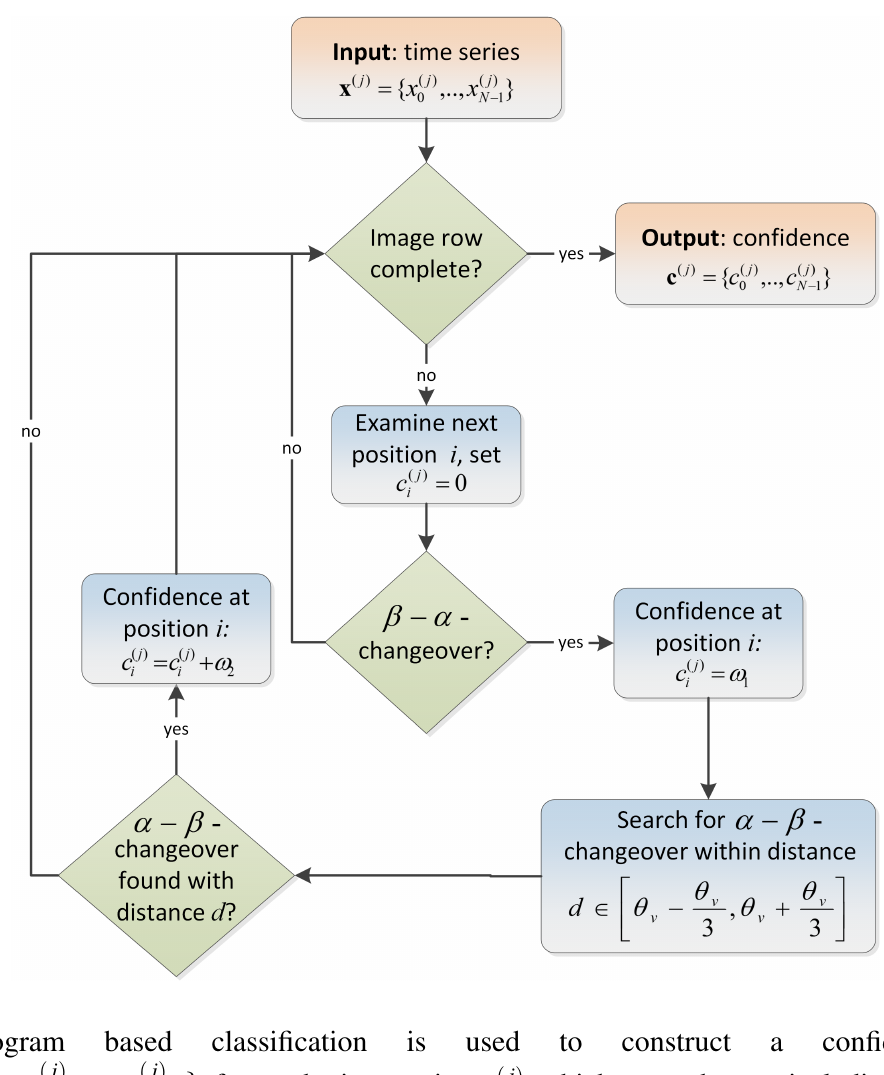
Figure 10. Flow chart for constructing confidence vectors c ( j ) for a particular time series x ( j ) . Input and output is visualized in Figure 11a,c. α represents predefined marker candidate pixels based on the RGB color model and β represents pixels from the rest of the